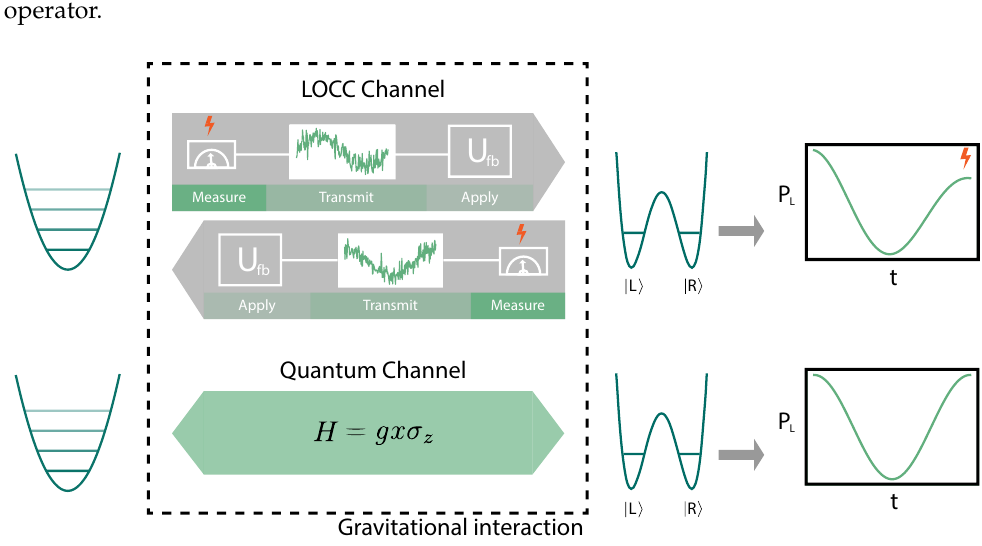
Figure 1. A particle trapped in a harmonic potential ( left ) and initialized in a thermal state interacts gravitationally with a lighter particle in a double-well potential ( right ). If the gravitational interaction is inherently classical it must admit an effective description as a local operations and classical commu- nications (LOCC) channel (upper half) between the two quantum systems. This in turn necessitates the conversion of quantum information into classical information via a measurement leading to back-action and therefore heating of the quantum systems (lightning bolt). This decoherence can be detected in an interferometric measurement on the lighter mass (see main text for details). Contrary to this case, if the gravitational interaction can be modeled as a quantum channel no excess decoherence is expected in the interferometric signal (lower